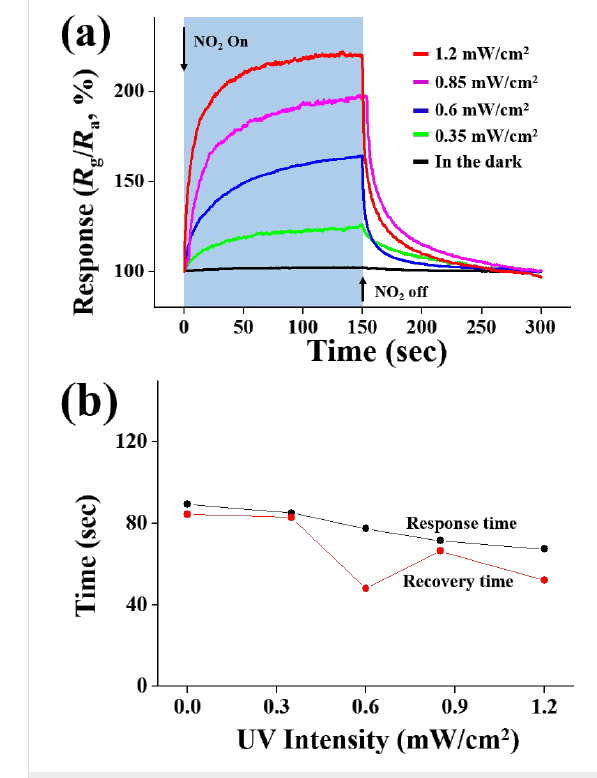
Figure 5: (a) Electrical response and (b) response and recovery times of ZnSe nanowire gas sensors under UV (365 nm) illumination for different UV illumination